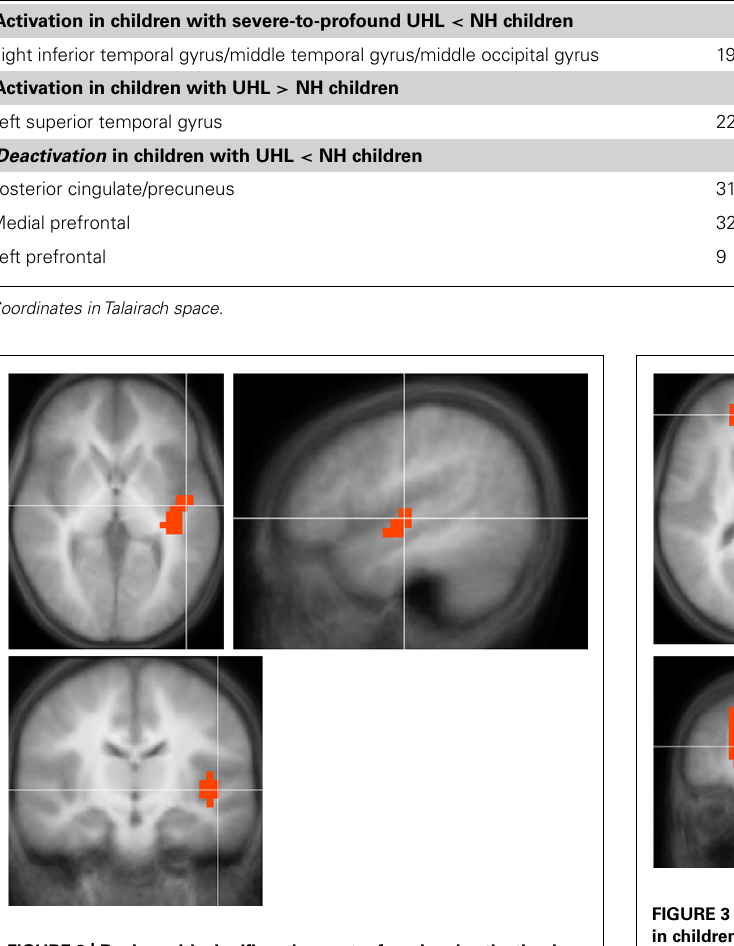
Table 4 | Regions with activation or deactivation differences between children with unilateral hearing loss (UHL) and normal-hearing (NH) children for the audio–visual “modified token” task. Region BA Coordinates Activation in children with severe-to-profound UHL < NH children Right inferior temporal gyrus/middle temporal gyrus/middle occipital gyrus